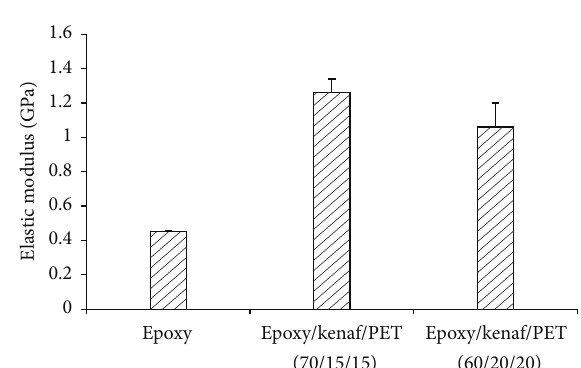
Figure 7: The results of tensile strength.